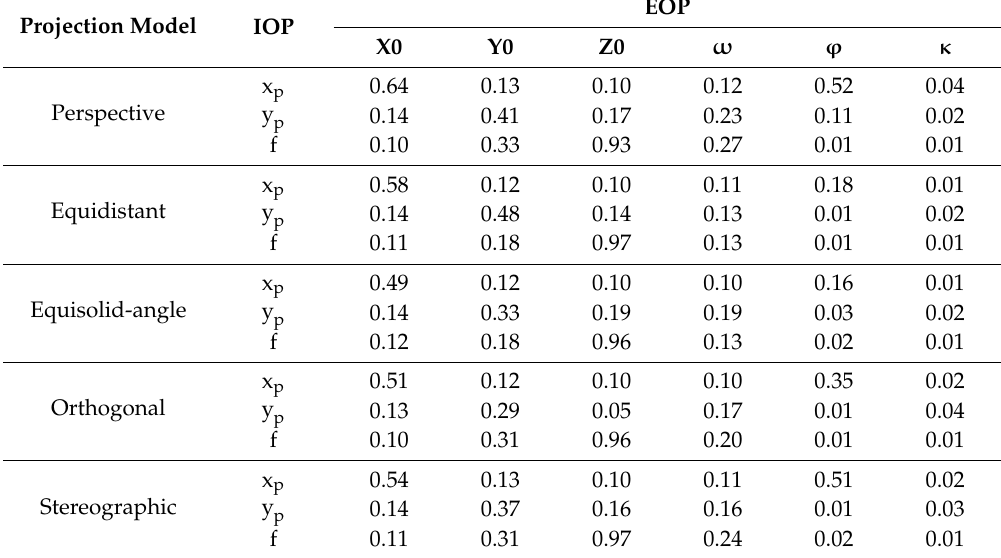
Table 6. Correlation between the orientation parameters (Plane-type test